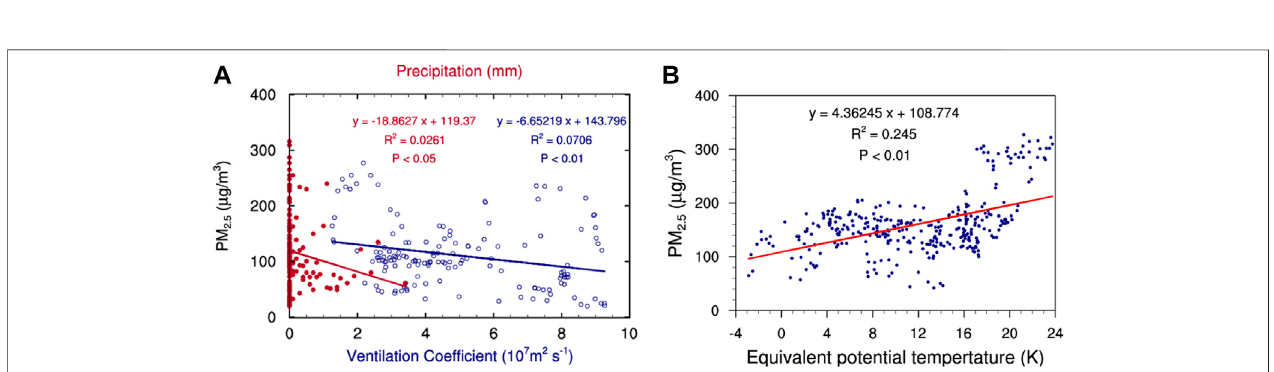
FIGURE 8 | Correlation of surface PM 2.5 concentration to precipitation (red solid circle) in JM in the later stage of (A) RTT, where the correlations are signi fi cant at 95%;correlationsofsurfacePM 2.5 concentrationtoventilation coef fi cient(bluehollowcircle,10 7 m 2 s − 1 )overtheregion(112 – 114 ° Eand30.5 – 31 ° N)averagedinthelater stage of (A) RTT, where the correlations are signi fi cant at 99%; correlation of surface PM 2.5 concentration to the difference in pseudo-equivalent potential temperature between the 700 hPa and 1,000 hPa ( Δ θ se) over the region (112 – 114 ° E and 30.5 – 31 ° N) averaged in the later stage of (B) SAT, where the correlations are signi fi cant at 99%. The later stage denotes the duration between the peak to the lowest PM 2.5 value over the sustained decrease